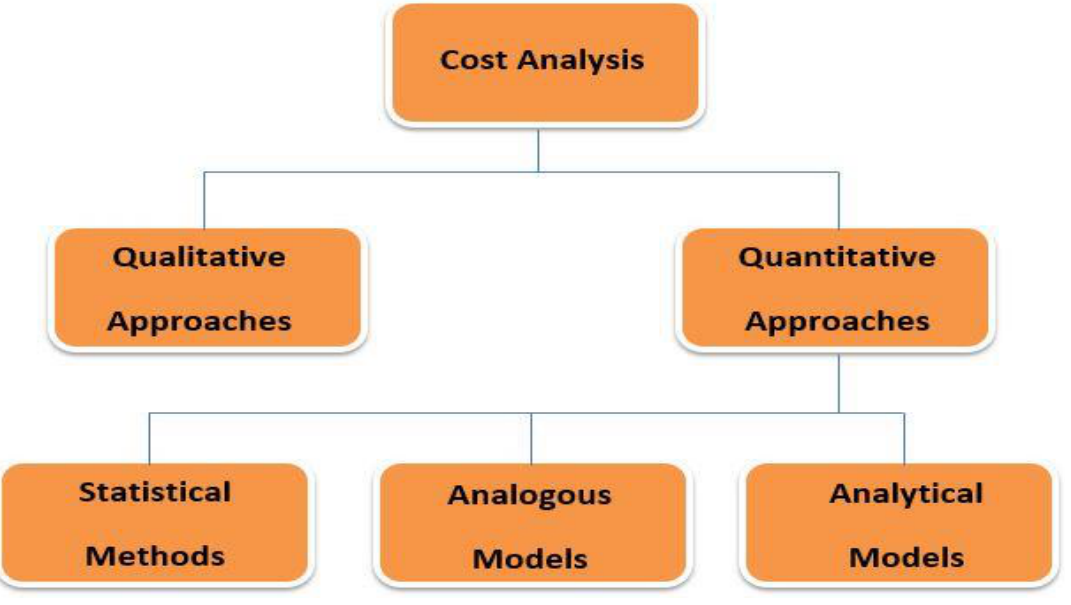
Figure 1. Representative diagram of modeling techniques dedicated to cost estimation.